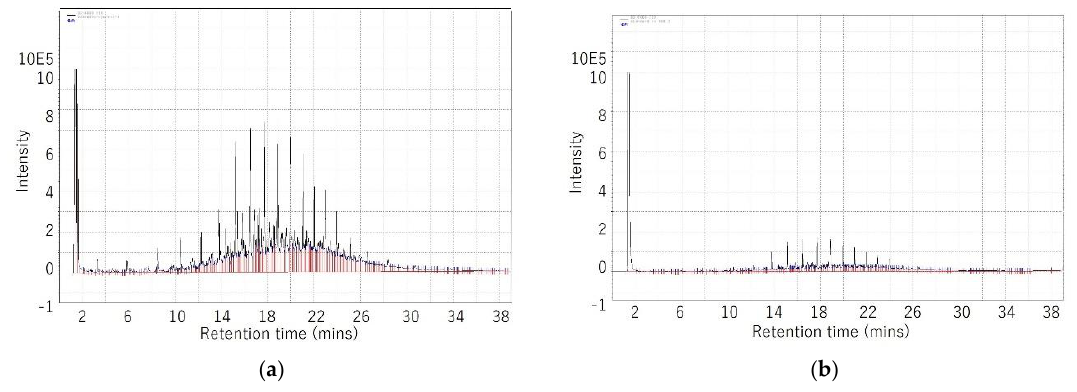
Figure 4. The representative GC-FID profile for ( a ) initial sample and ( b ) sample after 15 days of incubation.